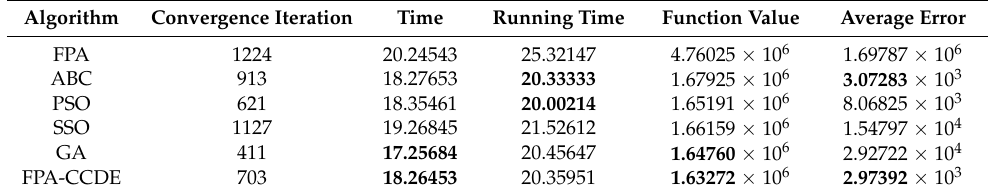
Table 6. Average objective function of each algorithm.